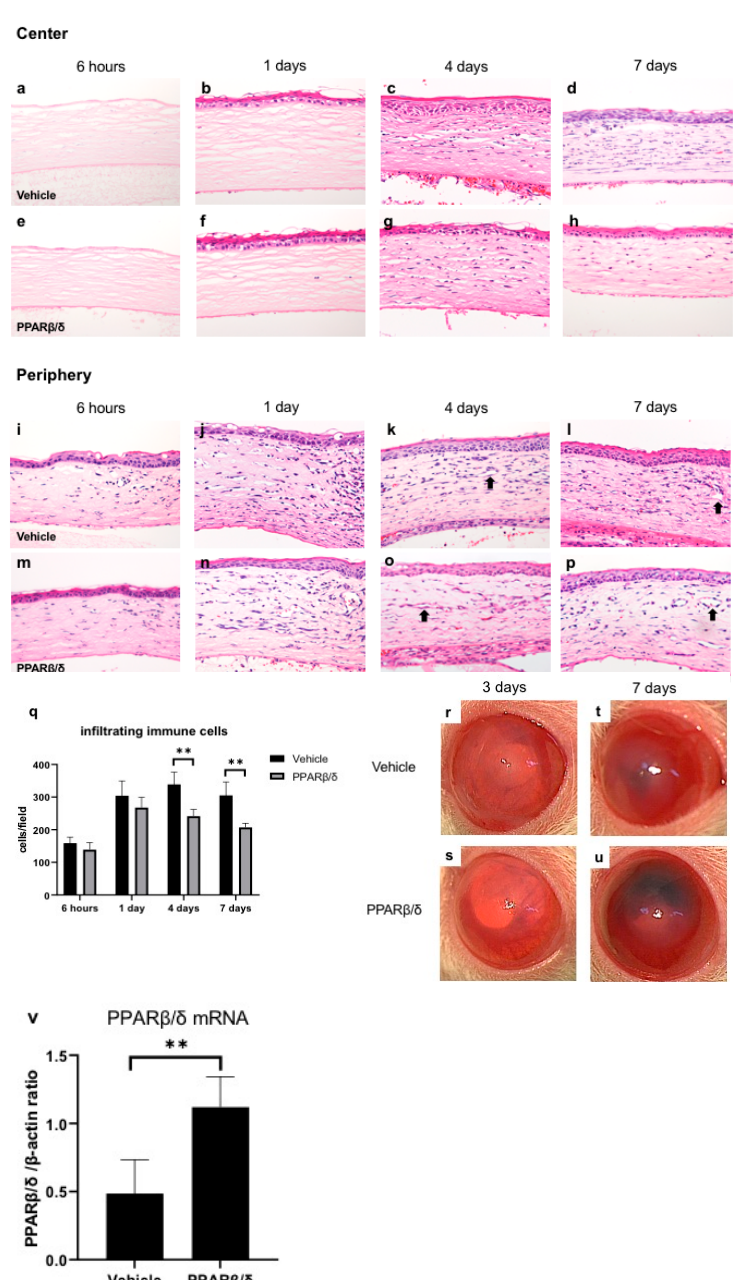
Figure 1. Wound healing process after alkali burn and expression of PPAR β / δ mRNA. The time-dependent changes in the vehicle group ( a–d : central region, i–l : peripheral region) and PPAR β / δ group ( e–h : central region, m–p : peripheral region). Bar, 50 µ m. After the alkali burn in both groups, inflammatory cells infiltrated from the corneal limbus into the central area by day 7. On day 4 and day 7, luminal structures (black arrows) due to neovascularization were observed. The number of infiltrating cells was lower in the PPAR β / δ group than in the vehicle group ( q ). The macroscopic photographs of anterior segment on day 3 ( r : vehicle group, s : PPAR β / δ group) and day 7 ( t : vehicle group, u : PPAR β / δ group). In the PPAR β / δ group, corneal transparency was better than the vehicle group on day 3, but on day 7, anterior chamber bleeding was deteriorated and transparency was lost. Regarding mRNA expression levels of PPAR β / δ , administration of the PPAR β / δ ligand significantly upregulated PPAR β / δ expression in the cornea at 6 h ( v ). ** p <